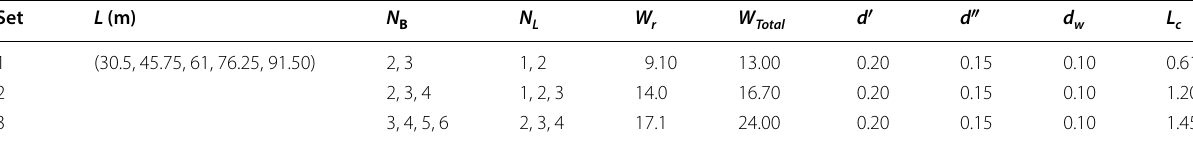
Table 1 Geometry of the bridges used in the parametric study (unit: m). Set L